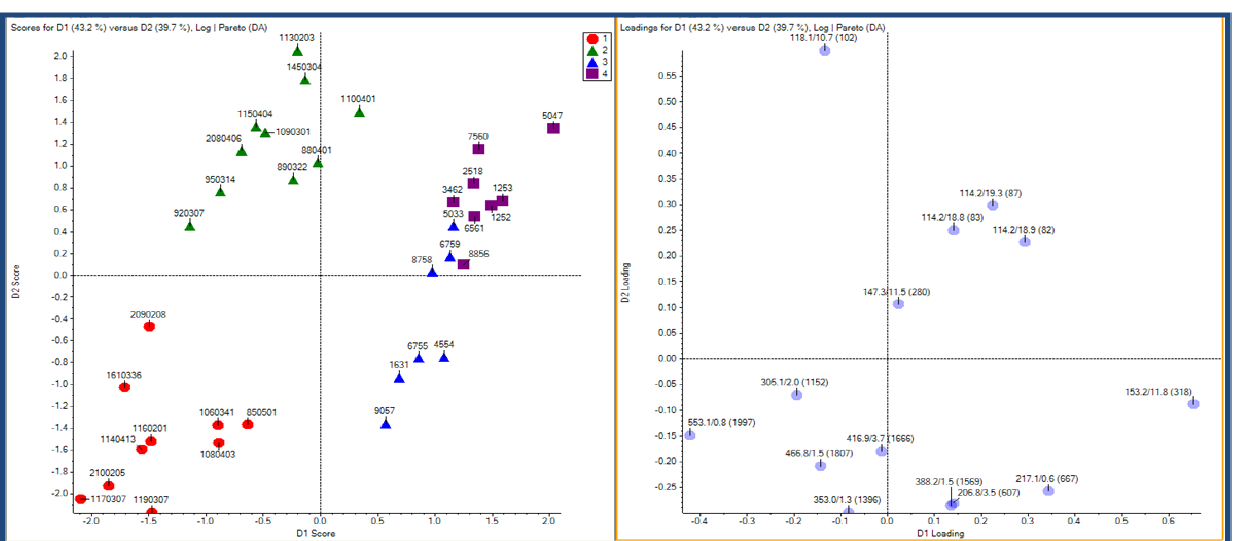
Figure 12. PCA-DA plot of the PKD HILIC-LC–ESI–MS after GA feature selection. Groups were color-coded as: 1-red: female PKD, 2-green: male PKD, 3- blue: female control, 4-purple: male control. Total 35 samples, 14 predictors.